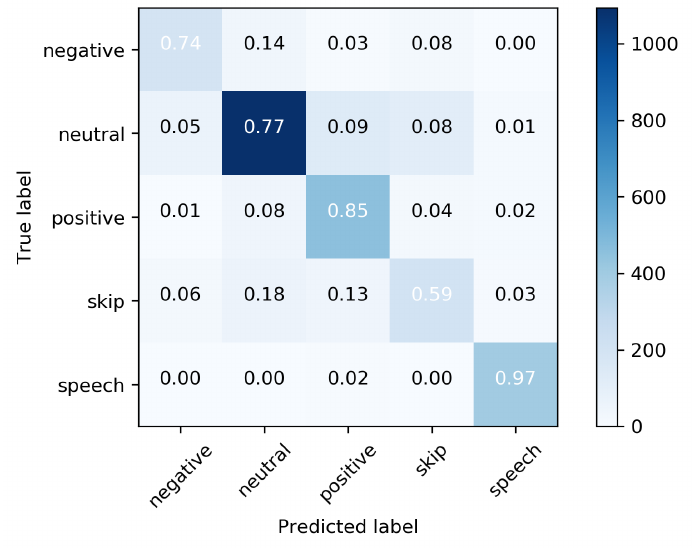
Figure 2. Normalized confusion matrix for RuRoBERTa-Large. The diagonal elements represent the share of objects for which the predicted label is equal to the true label (i.e., Recall), whereas off-diagonal elements are those that are mislabeled by the classifier. The higher the diagonal values of the confusion matrix the better, indicating many correct predictions. The color bar represents the number of objects classified in a particular way, where the light blue color represents zero objects and dark blue represents the maximum amount of